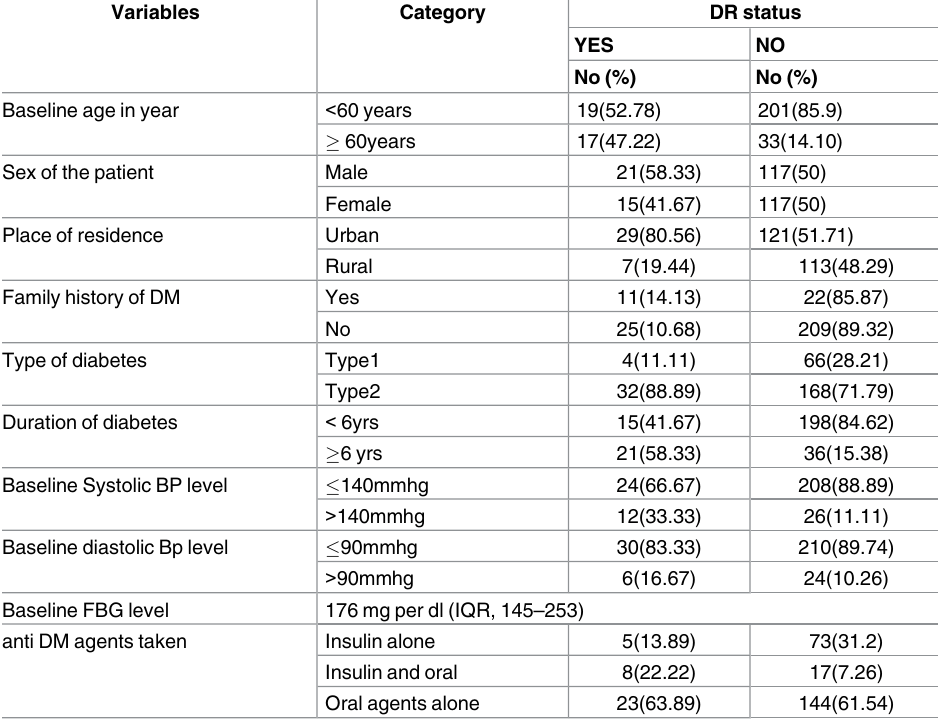
Table 1. Descriptive statistics with DR status of diabetic patients in Arbaminch general hospital, 2015/16, (n = 270).